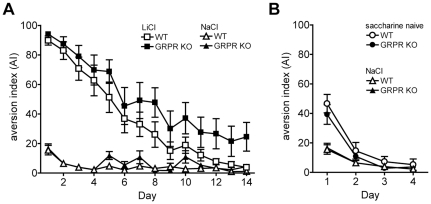
GRPR KO animals showed no differences in conditioned tast aversion (CTA) or neophobia.
A) CTA was evoked by pairing a novel taste, saccharin, with a LiCl injection to induce illness the day before testing (LiCl; n = 12 mice per group). Control animals were offered the novel taste saccharin but injected with NaCl (NaCl groups; n = 11 mice per group) or given only water to drink and injected with NaCl the previous day (saccharin naive groups; n = 12 mice per group). B) Attenuation of neophobia and neophobia were assessed by comparing the aversion to saccharin on first exposure (saccharin naive) with the aversion shown by mice that were exposed to saccharin the previous day (NaCl). On successive days the neophobia was attenuated by repeatedly being given the chance to drink saccharin flavored water.